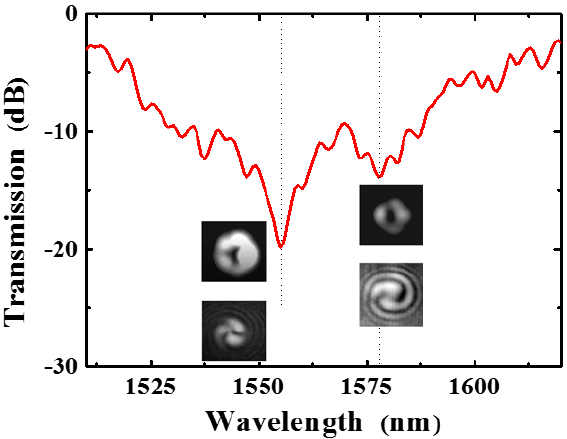
Figure 23. The measured transmission spectrum of the fabricated HLPG, where the insets show the intensity and phase distributions of the OAM-3 mode observed at wavelength of 1555.0 nm, and those of the OAM-2 mode observed at wavelength of 1578.0 nm, respectively. Adapted with permission from Ref. [47] © The Optical Society.